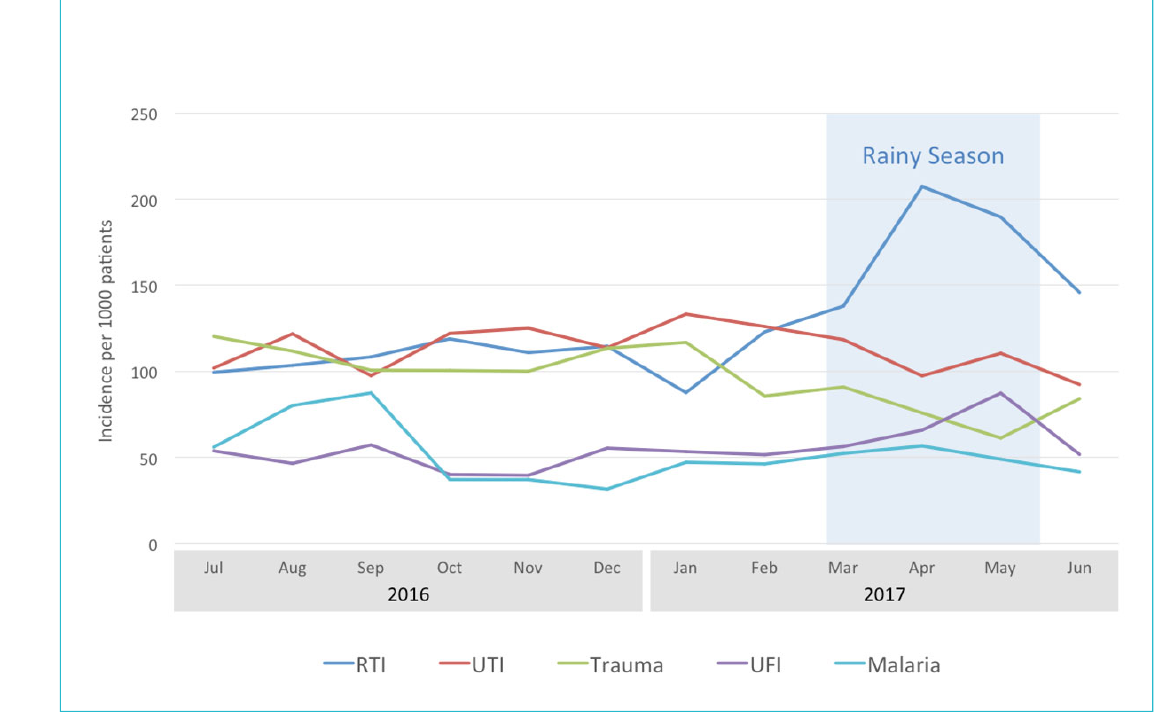
Figure 4: Incidence of the five most common diagnoses per 1000 patients per month. Monthly incidences of the five most common diseases, diagnosed at the emergency department in 35’903 patients from July 2016 through to June 2017. ‒ RTI: respiratory tract infection; UTI, urinary tract infection; UFI, undifferentiated febrile